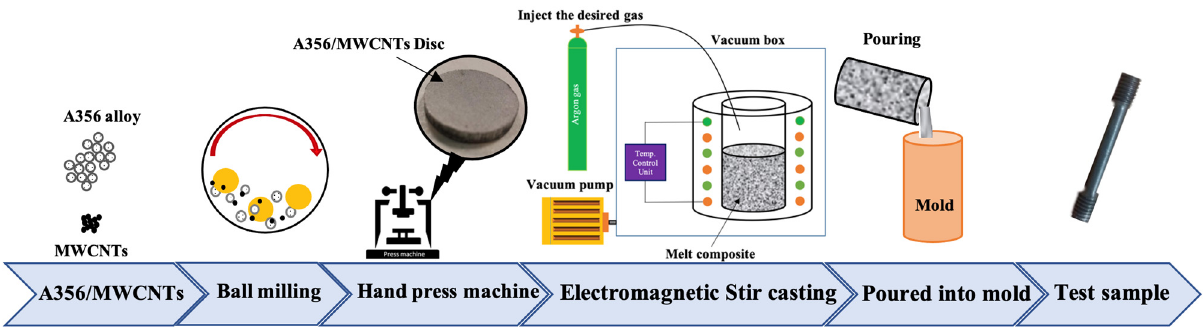
Figure 1. Schematic of manufacturing